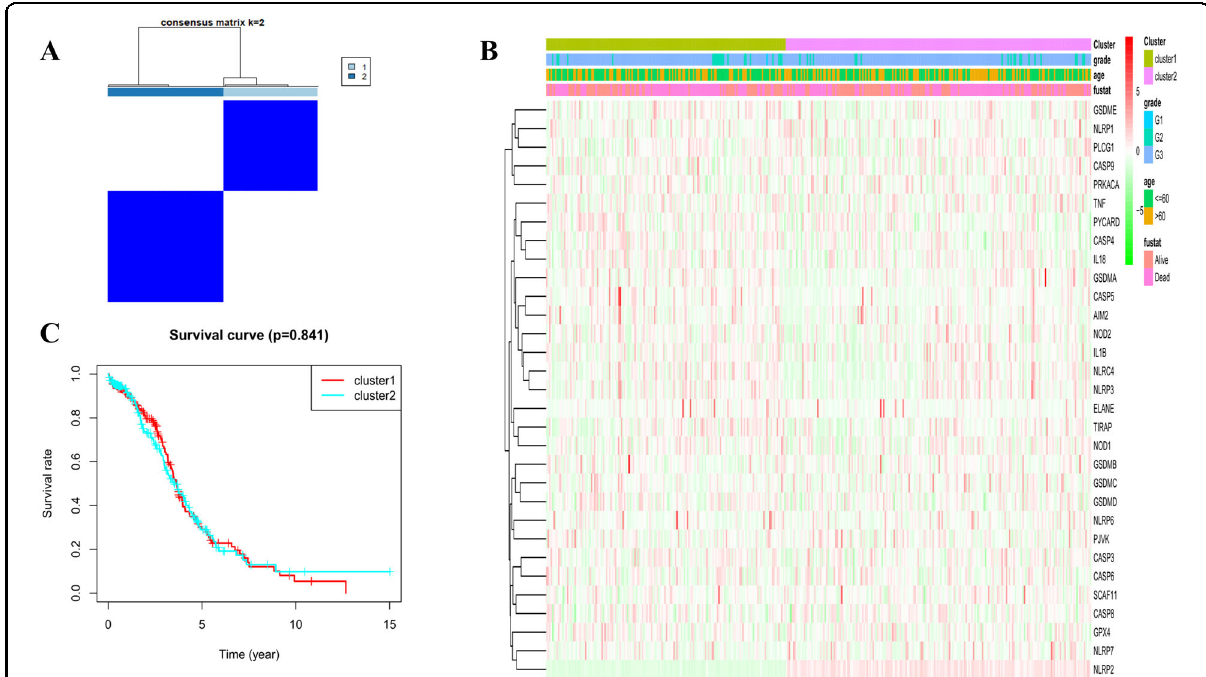
Fig. 2 Tumour classi fi cation based on the pyroptosis-related DEGs. A 379 OC patients were grouped into two clusters according to the consensus clustering matrix ( k = 2). B Heatmap and the clinicopathologic characters of the two clusters classi fi ed by these DEGs (G1, G2, and G3 are the degree of tumour differentiation. G1: High differentiated; G2: Moderate differentiated; G3: Poor differentiated). C Kaplan – Meier OS curves for the two